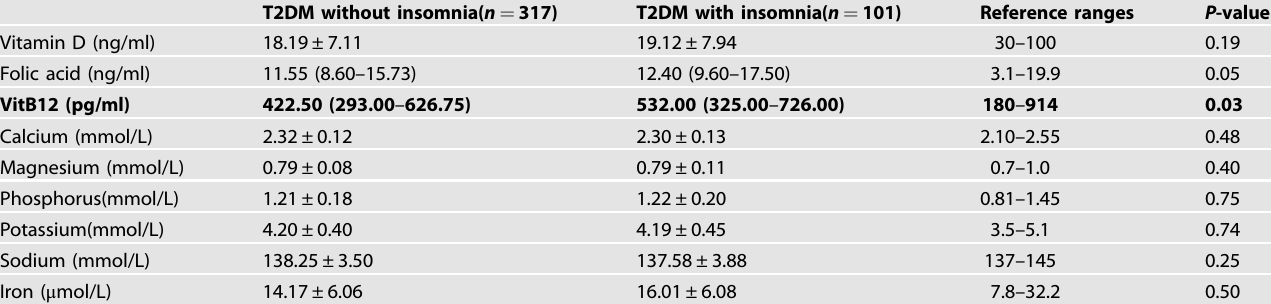
Data are means ±SD or median (interquartile ranges) for indicated number of patients in each group. P values for comparisons between groups are based on unpaired t test or Mann – Whitney Test (when the data are not normally distributed). Bold entries represent signi fi cant p values. The P <0.05 is considered to be signi fi cant. Bold entries represent signi fi cant p values.